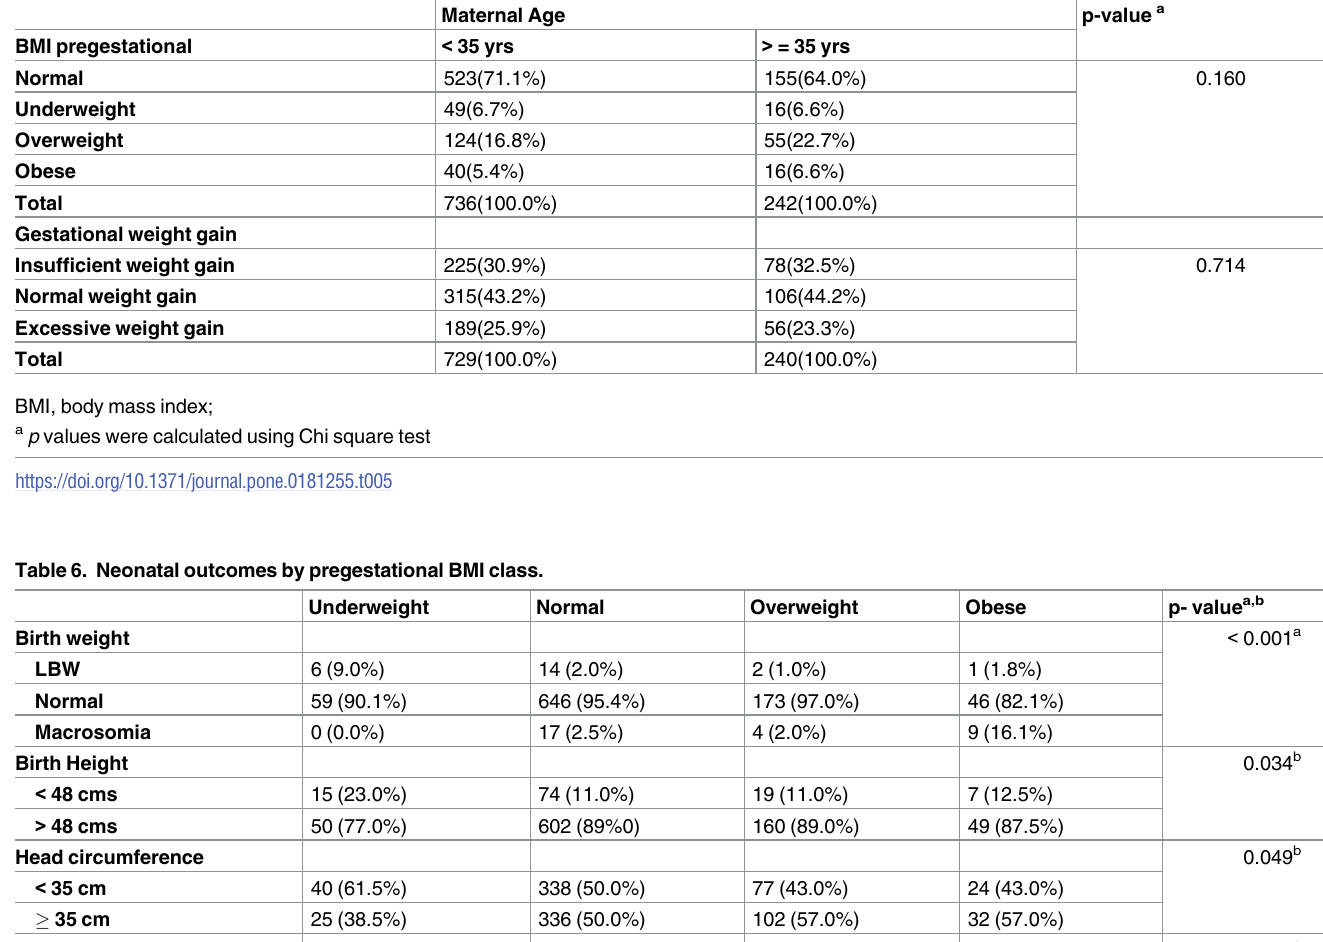
Table 5. Association between maternal age, BMI & GWG.